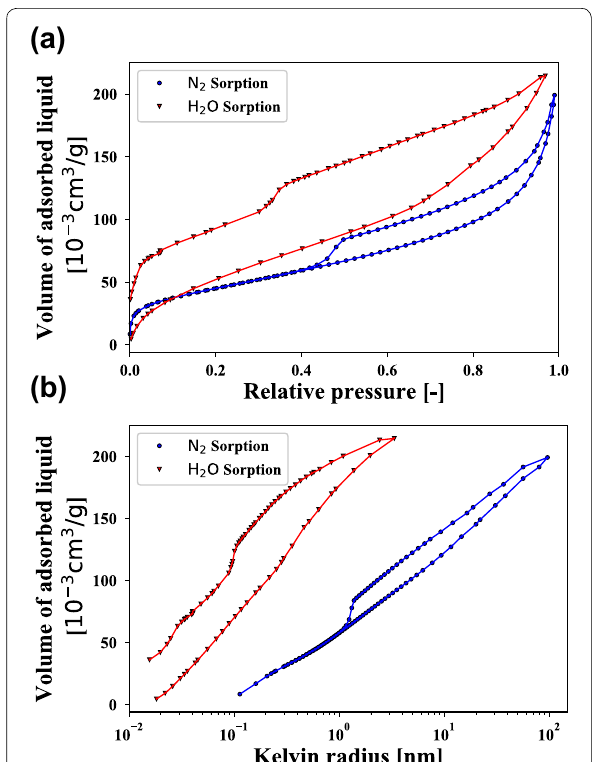
Fig. 3 Comparison of nitrogen and water vapor sorption isotherm of samples stored in lime water, a as a function of relative pressure, b as a function of Kelvin radius, data from Maruyama et al. (